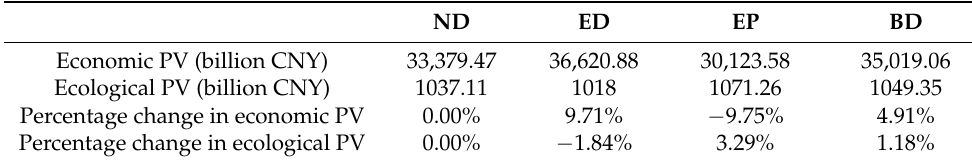
Table 11. Comparative analysis of benefits under four scenarios in 2030. ND ED EP BD Economic PV (billion CNY)